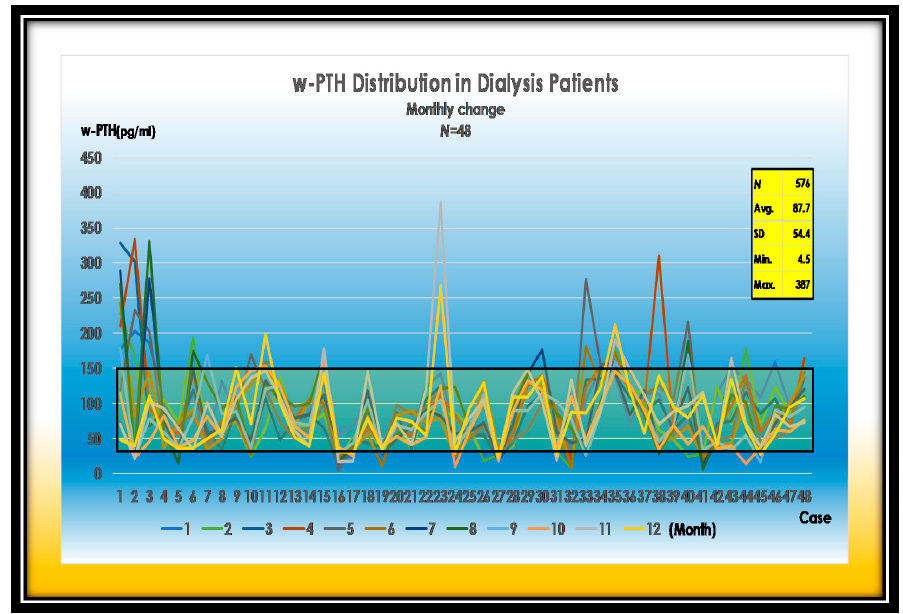
Figure 5. Changes in w-PTH levels in 48 dialysis patients. Average of w-PTH is 87.7 pg/mL. SD is 54.4 pg/mL. Maximum of w-PTH is 387 pg/mL. w-PTH—whole-PTH. w-PTH is relatively easy to control by CaSREs (Evocalcet or Etelcalcetide) and active VitD 3 (Figure 6).